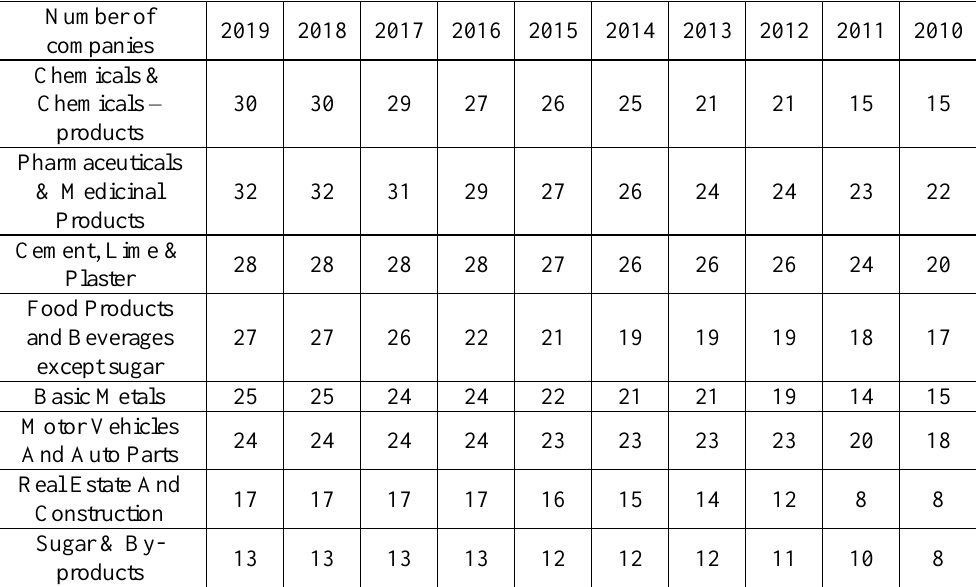
Table 1 . Number of Companies in each